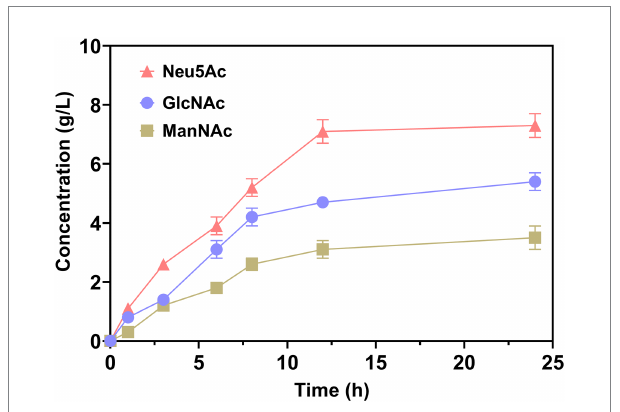
FIGURE 4 Neu5Ac production from chitin using enzyme cascade.